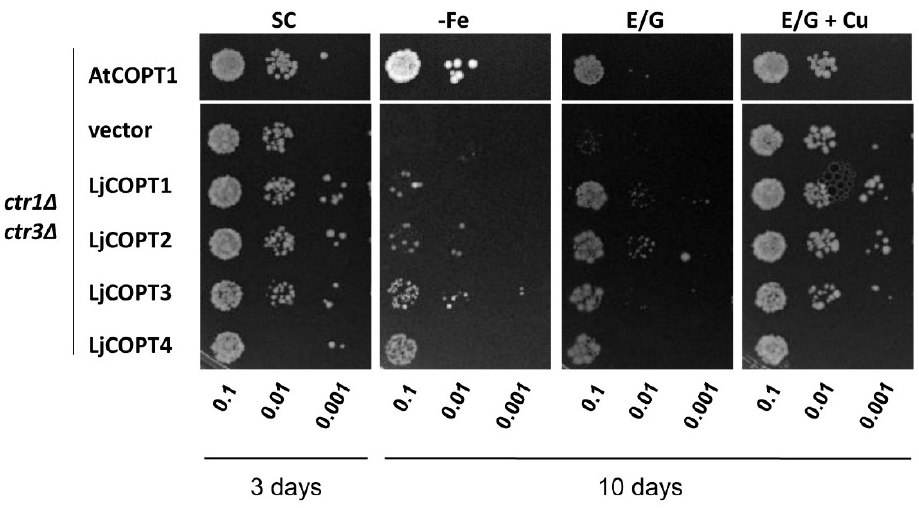
Figure 4. Functional complementation of copper transporter 1 and copper transporter 3 ( ctr1 ∆ ctr3 ∆ ) Saccharomyces cerevisiae mutant. The ctr1 ∆ ctr3 ∆ mutant was transformed with empty vector (p426GPD; negative control). The same vector expressing Arabidopsis thaliana AtCOPT1 (positive control) and LjCOPT1, LjCOPT2, LjCOPT3, or LjCOPT4. Cells were grown at 30 ◦ C on glucose (SC-ura) plates or